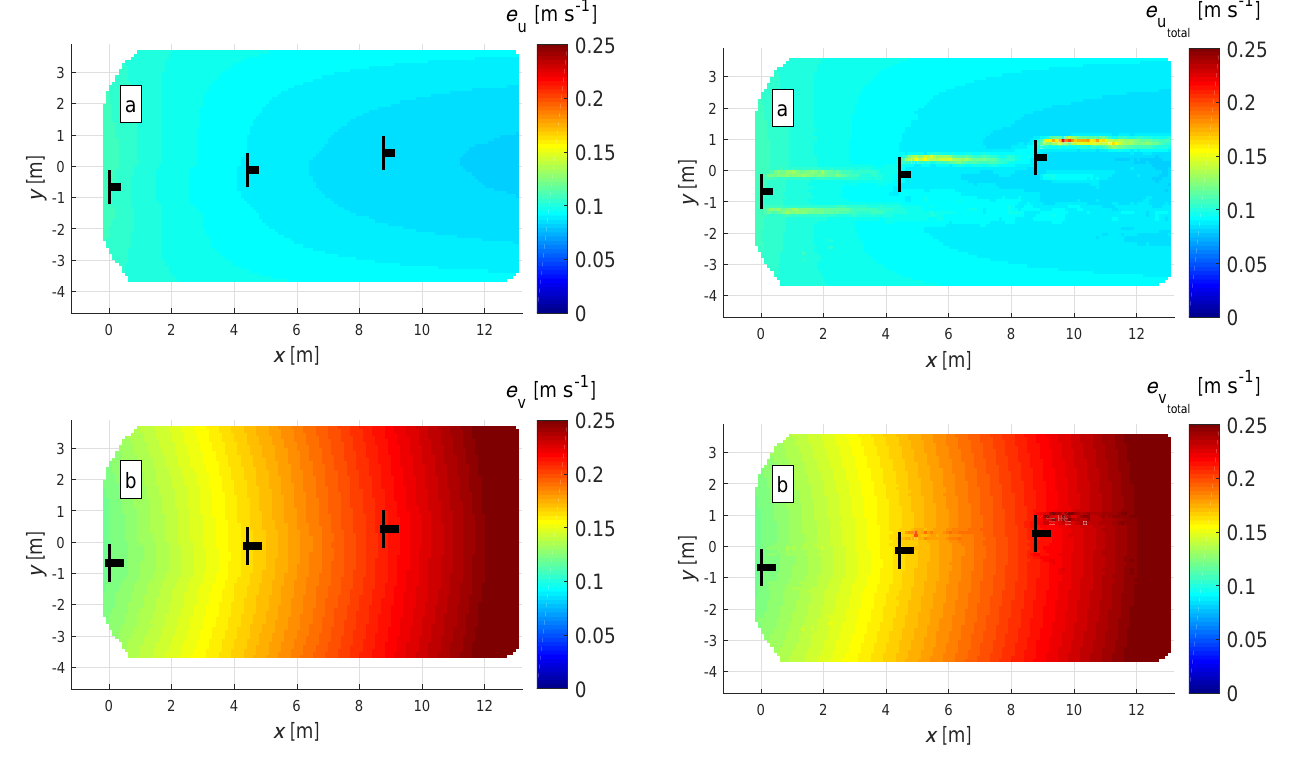
Figure 25. Dual-Doppler uncertainty on the evaluated u (a) and v (b) components.